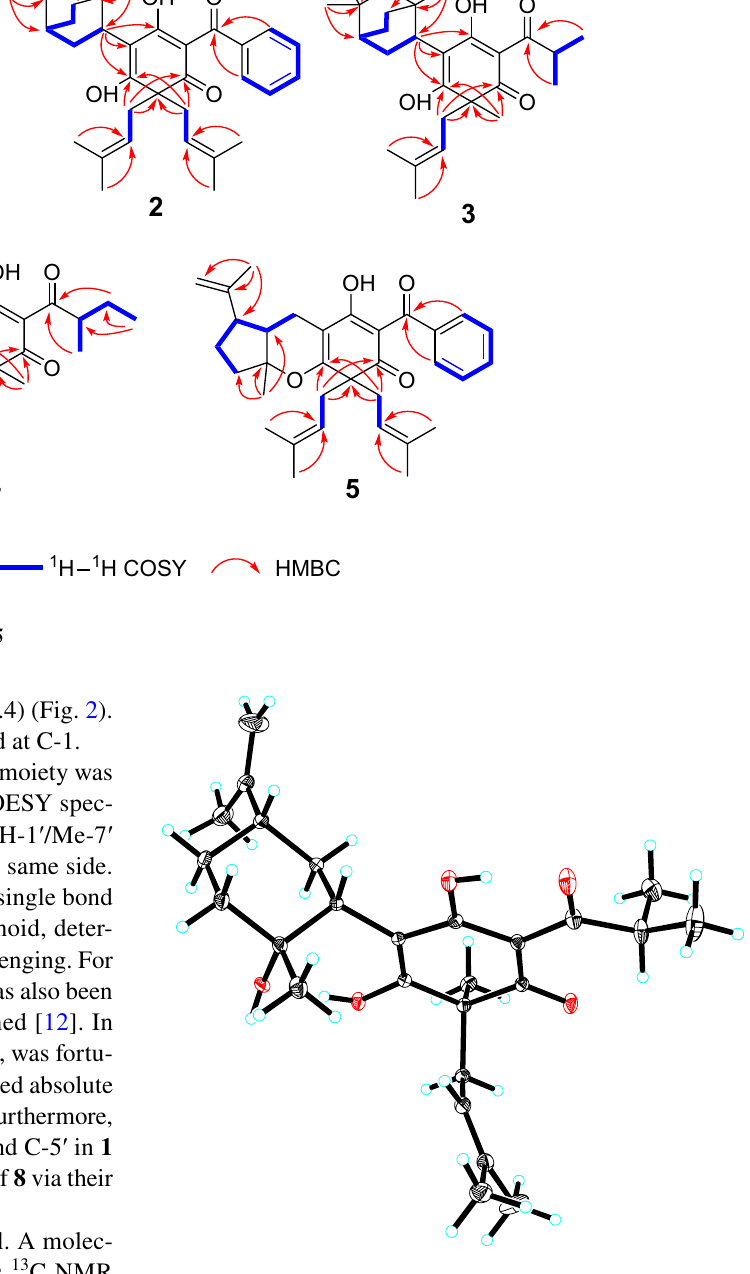
Fig. 3 X-ray structure of compound